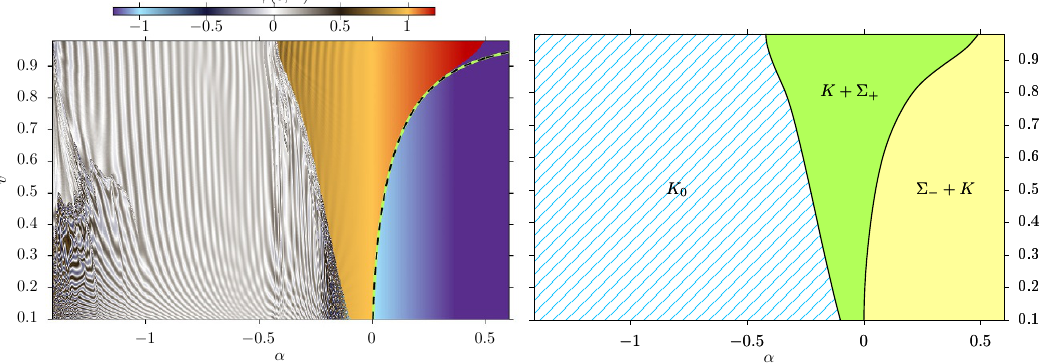
Figure 23 . Di(cid:11)erent scenarios of kink-impurity ((cid:6) (cid:0) + K ) collisions. The left plot shows the (cid:12)eld value at center at time T after the collision. The right plot shows the products of the collisions. Line (cid:12)lled regions correspond to chaotic